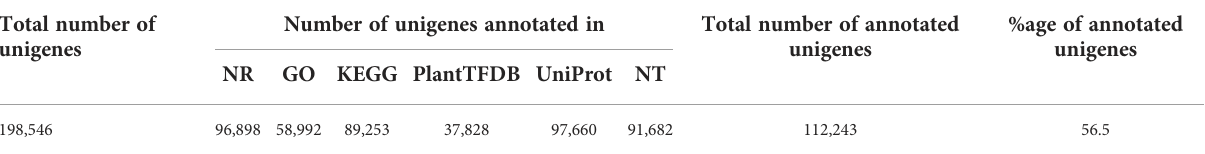
TABLE 3 The number of unigenes annotated in each of the six major databases. Total number of unigenes